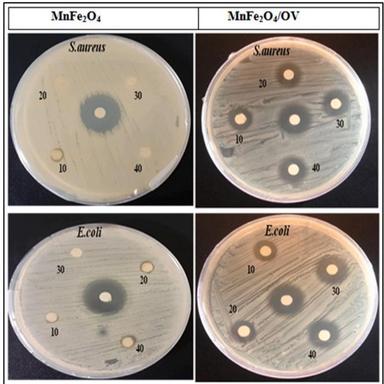
Zone of inhibition formation around paper disc loaded with different concentrations of samples, in centre streptomycin as a reference.